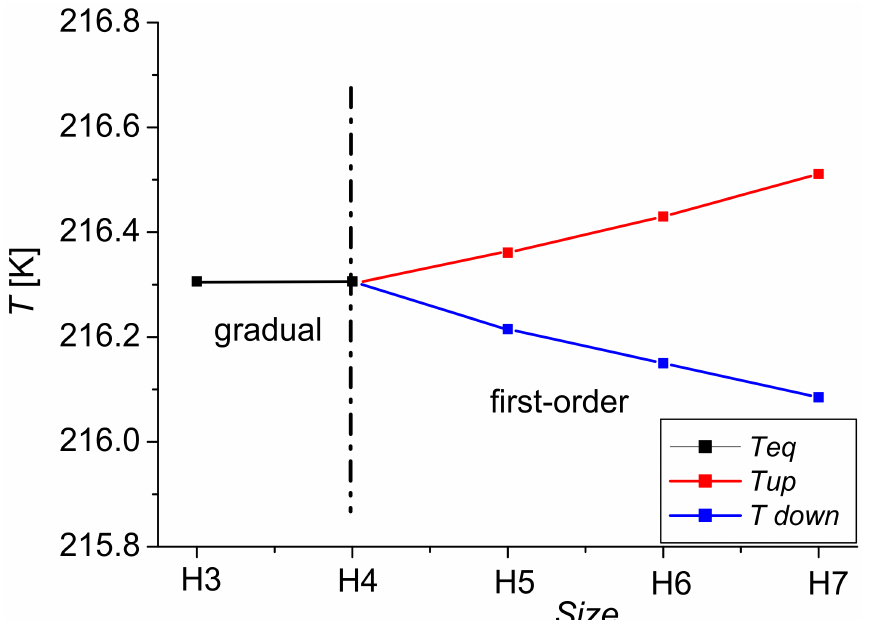
Figure 3. Lower ( T down = T HS − T LS ) and upper ( T up = T LS − T HS ) transition temperatures of the total HS fraction of Figure 2 as a function of the size of the system.